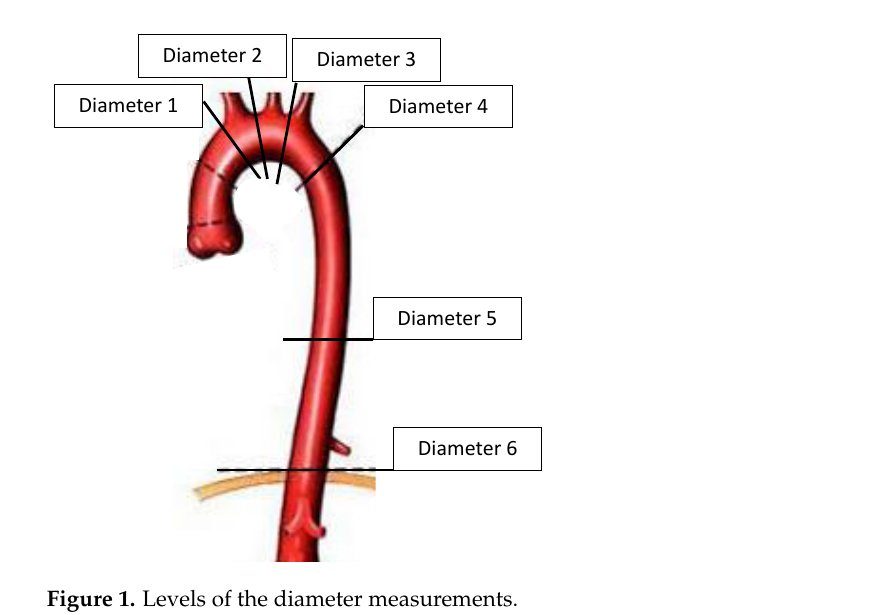
Figure 1 . Levels of the diameter measurements. Figure 1. Levels of the diameter